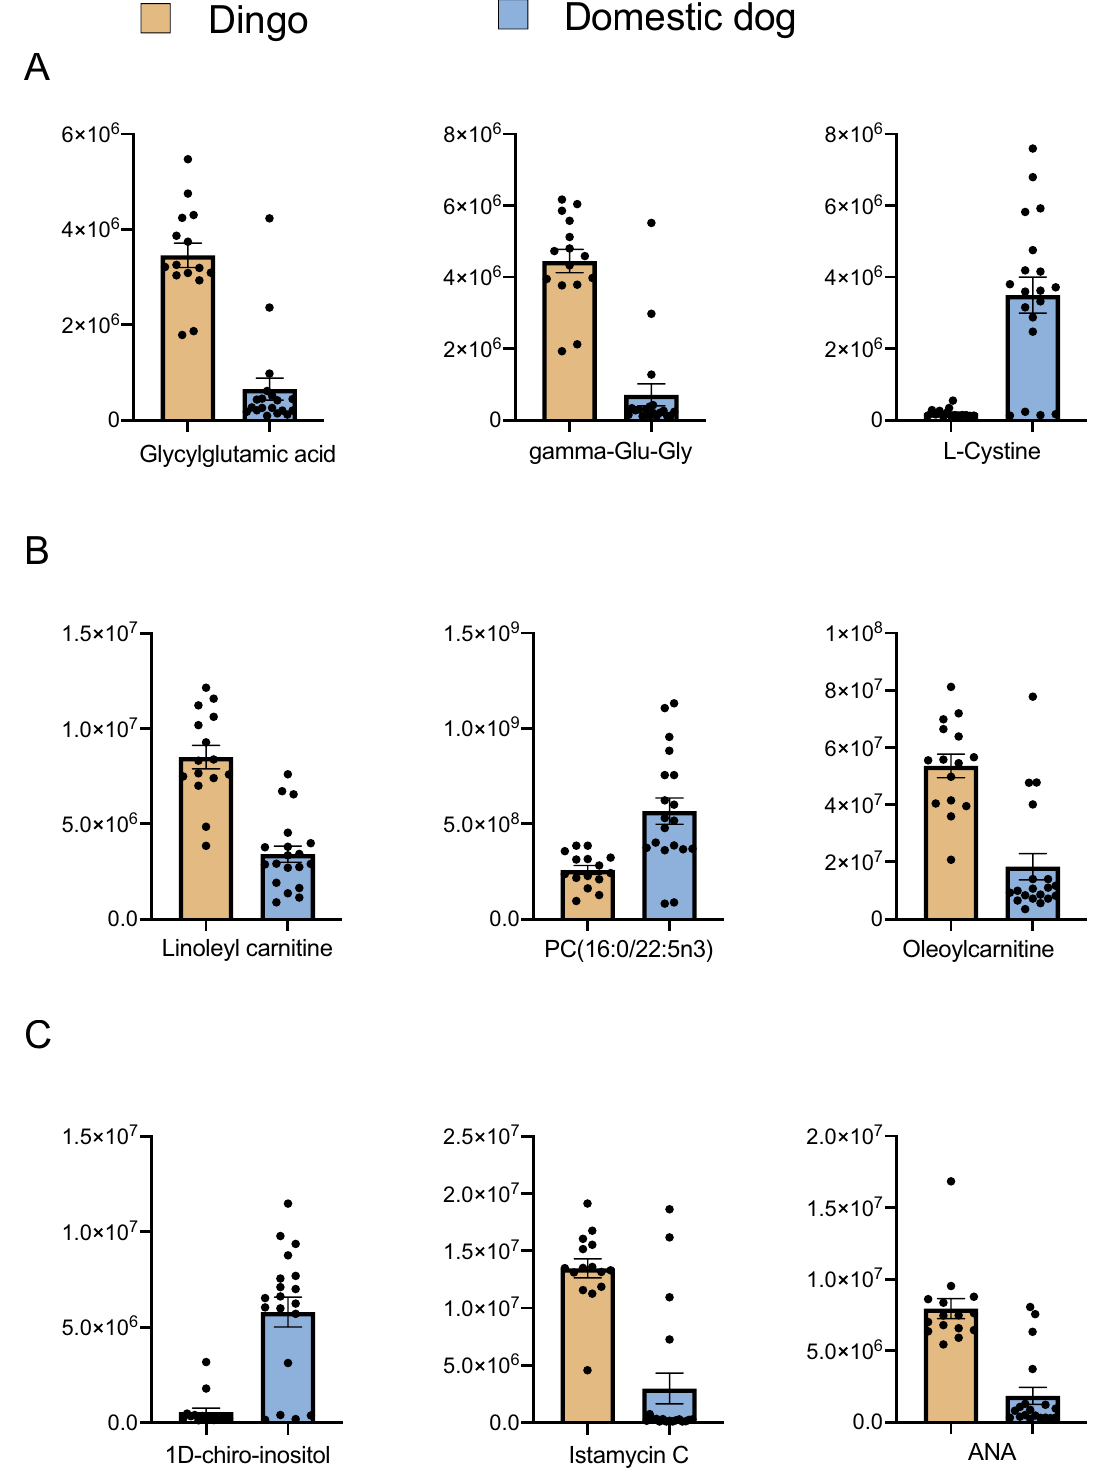
Figure 1. Top three metabolite differences between dingoes and domestic dog breeds jointly based on the lowest P- values: ( A ) Top three protein metabolite differences, ( B ) Top three lipid metabolite differences, ( C ) Top three carbohydrate metabolite differences. ANA: 2,7-Anhydro-alpha-N-acetylneuraminic acid (sialic acid). Y axis represents normalised area for the metabolite. Plot show mean with